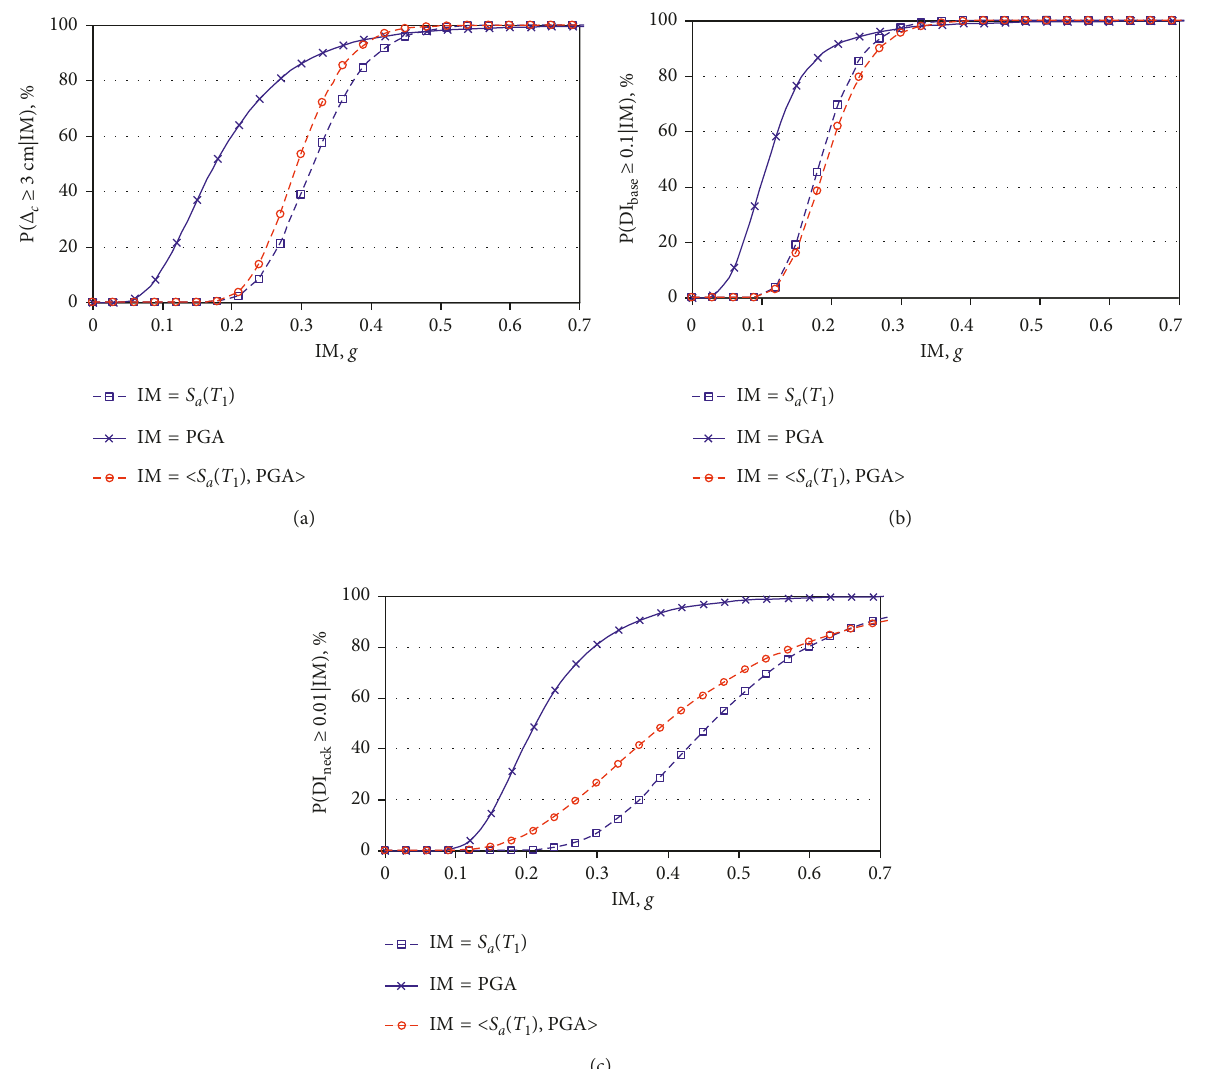
Figure 11: Seismic fragility curves considering the scalar and vector IMs to predict (a) Δ